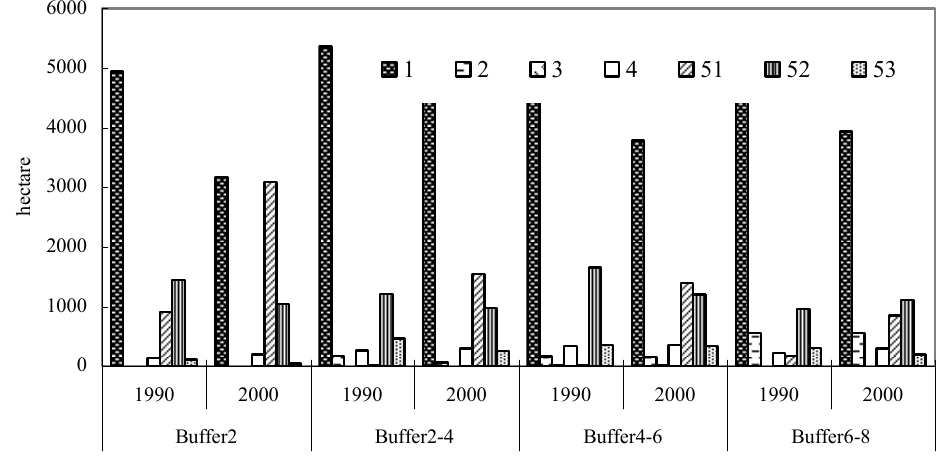
Figure 7. Land use changes along the buffered belts from Badaling